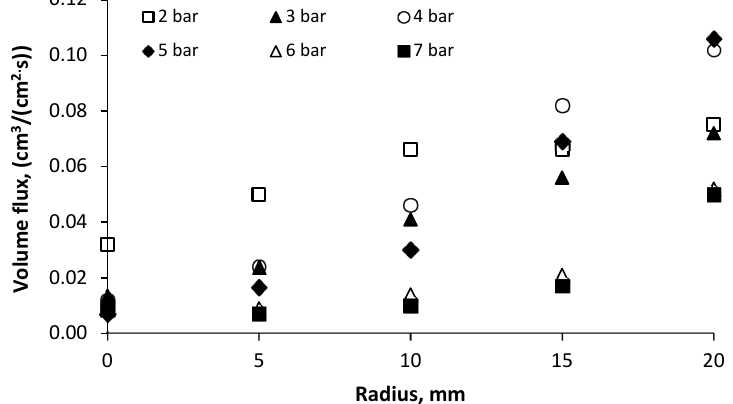
Figure 7. Axial droplet velocity vs radius for different water pressures.